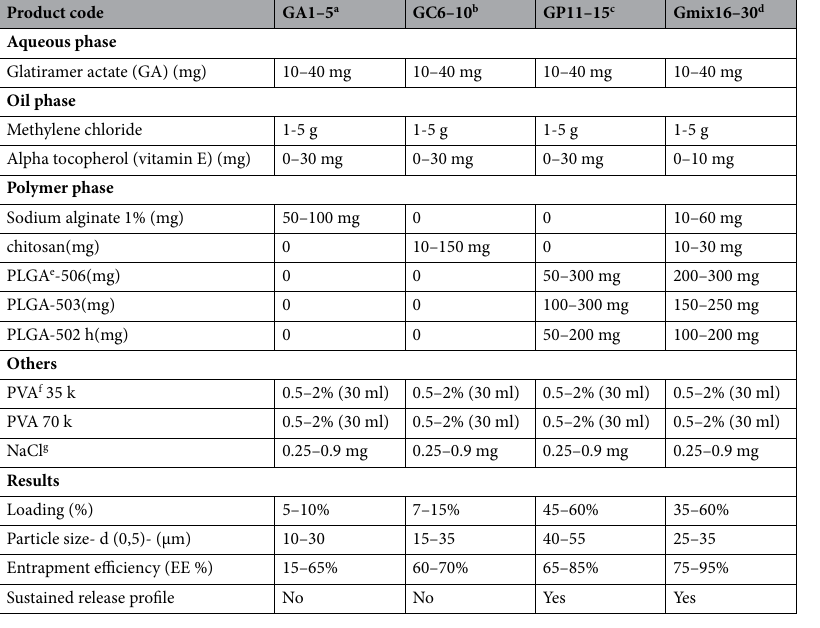
Table 1. Formulations of PLGA hydrogel microparticles (a: products contain only sodium alginate, b: products contain only chitosan, c: products contain only PLGA, d: products contain sodium alginate, chitosan and/or PLGA, e: poly (lactic-co-glycolic acid), f: Poly Vinyl Alcohol, g: Sodium